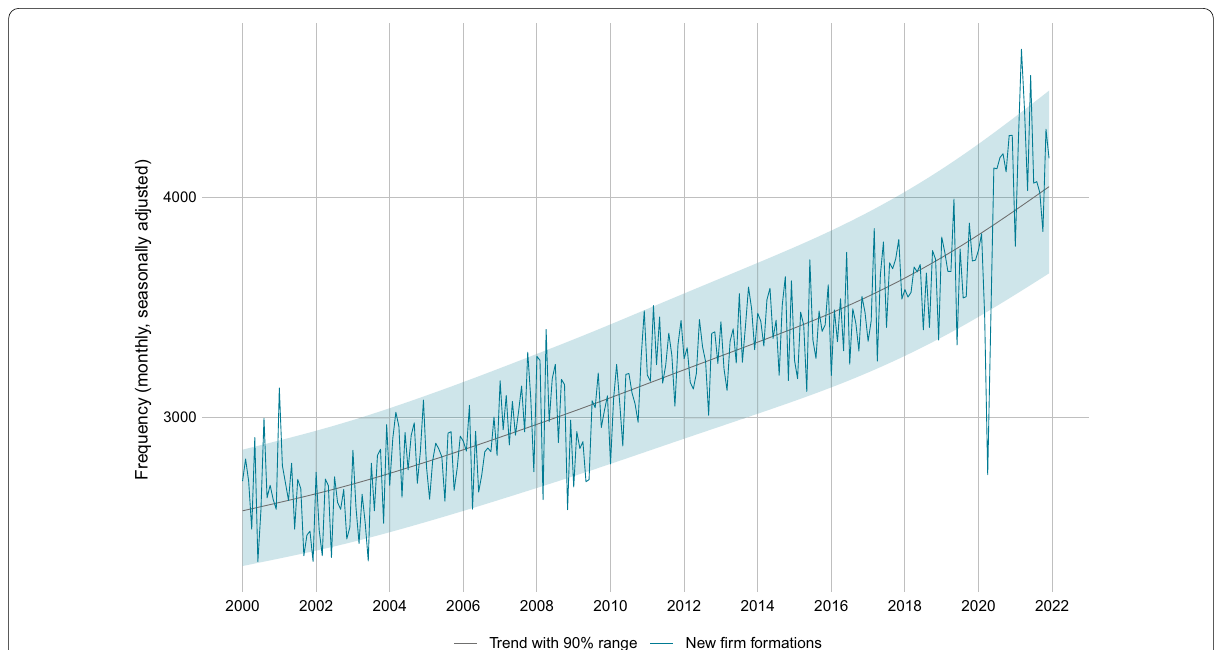
Fig. 12 Monthly frequency of firm start-ups in Switzerland. Notes : The figure shows the monthly seasonally adjusted frequency of new firm formations in Switzerland, together with a trend and the 90% probability range